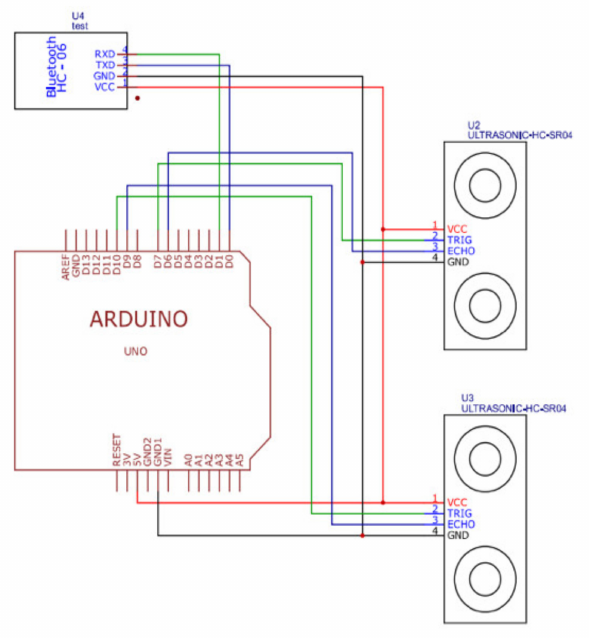
Figure 5. Circuit diagram of the ultrasonic counter device.